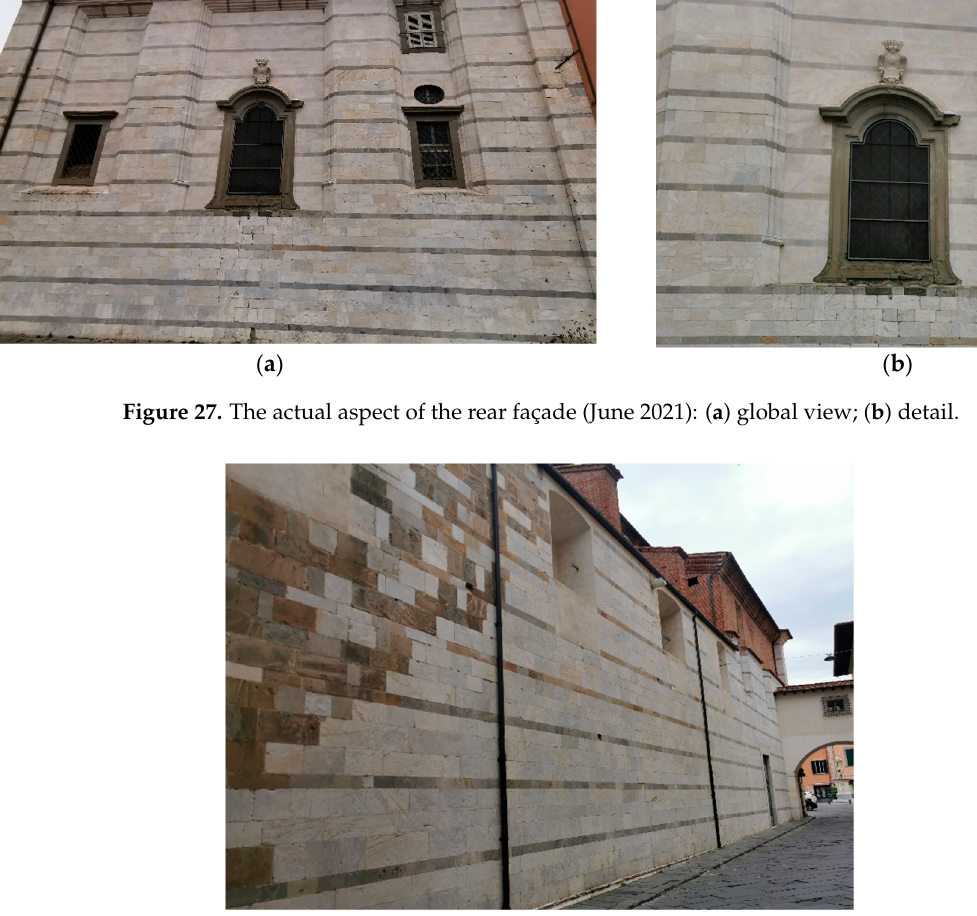
Figure 28. The actual aspect of the south façade (June 2021).